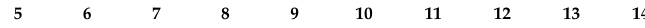
Table 2. Descriptive statistics and correlations for study variables for